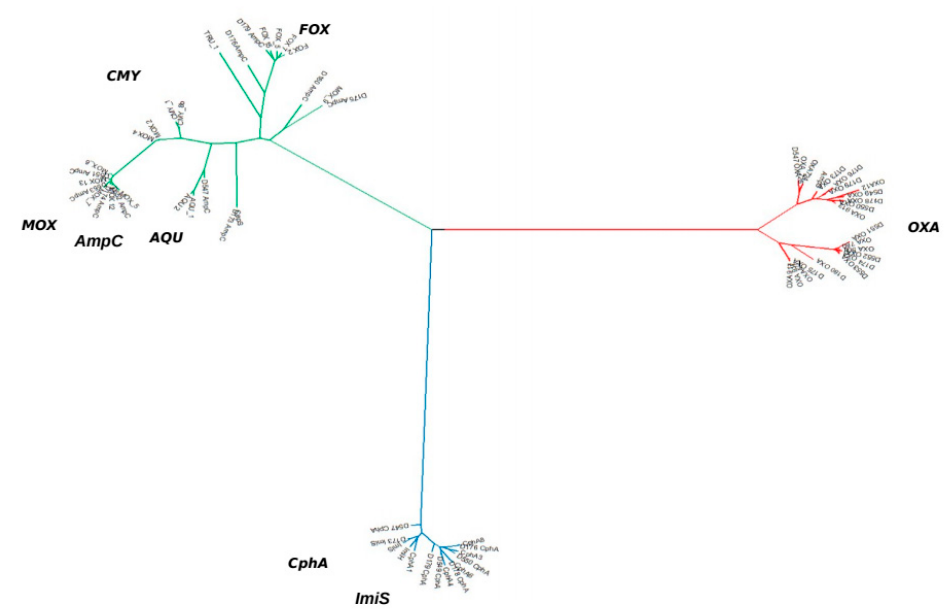
Figure 2. UPGMA tree containing all β -lactamase resistance genes found in Aeromonas isolates. Class B β -lactamase branch is coloured in blue, Class C β -lactamase branch is coloured in green, and Class D β -lactamase branch is coloured in red. Analyses of the 65 nucleotide sequences were performed using MEGA X.